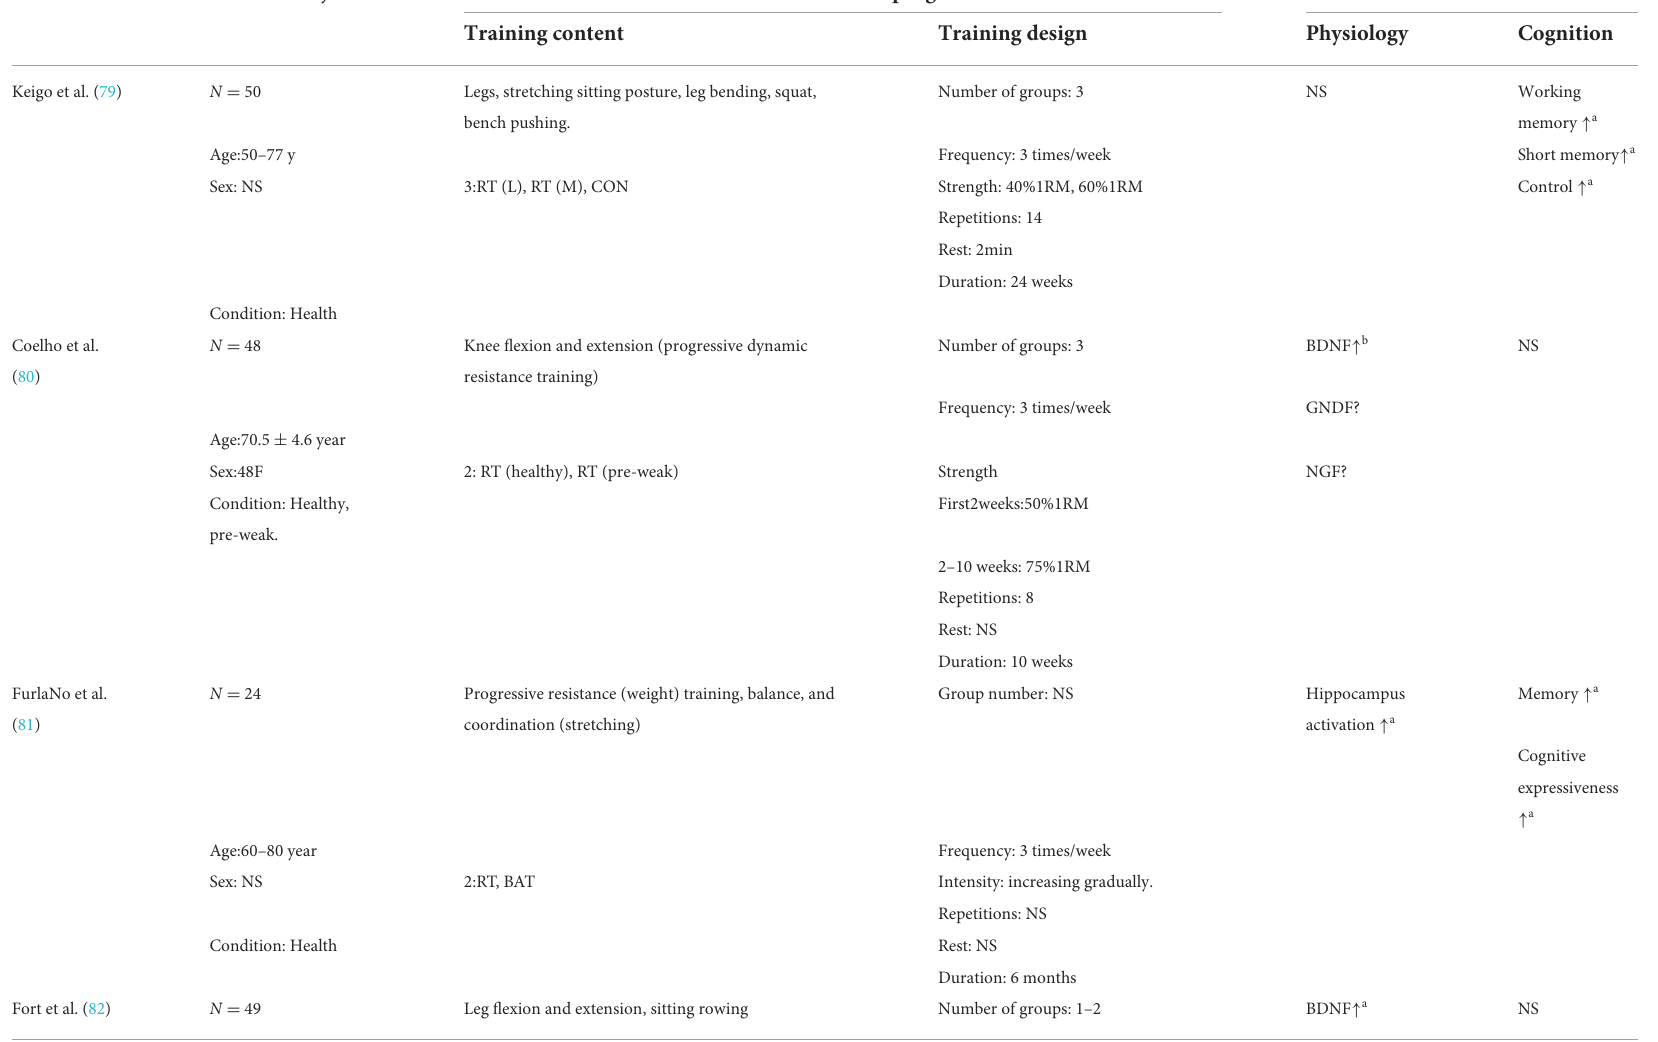
TABLE 2 Effect of chronic resistance exercise on the cognitive function of the